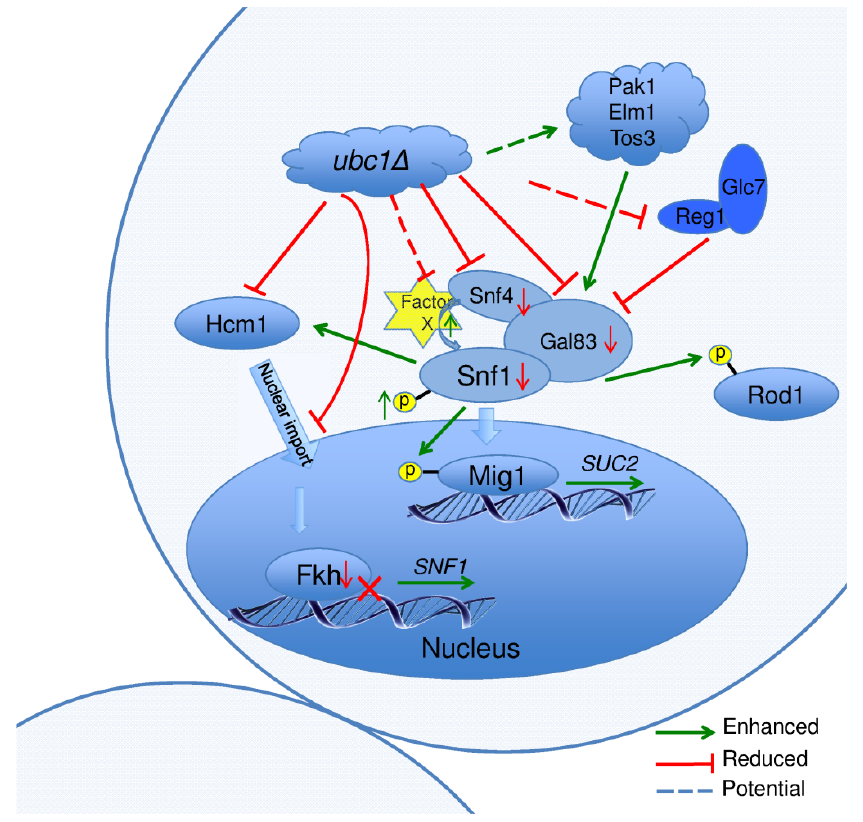
FIGURE 8: Schematic model of Ubc1- dependent mechanisms and their potential targets impacting